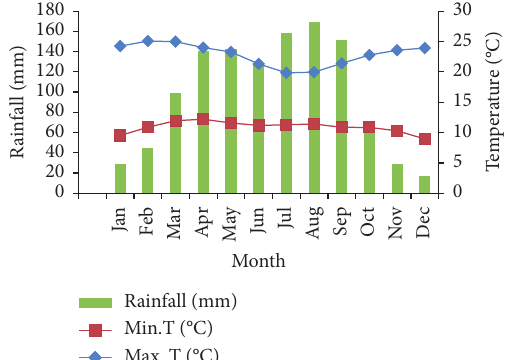
Figure 2: Mean monthly rainfall; mean monthly maximum and minimum temperatures (1990–2018) of the study area